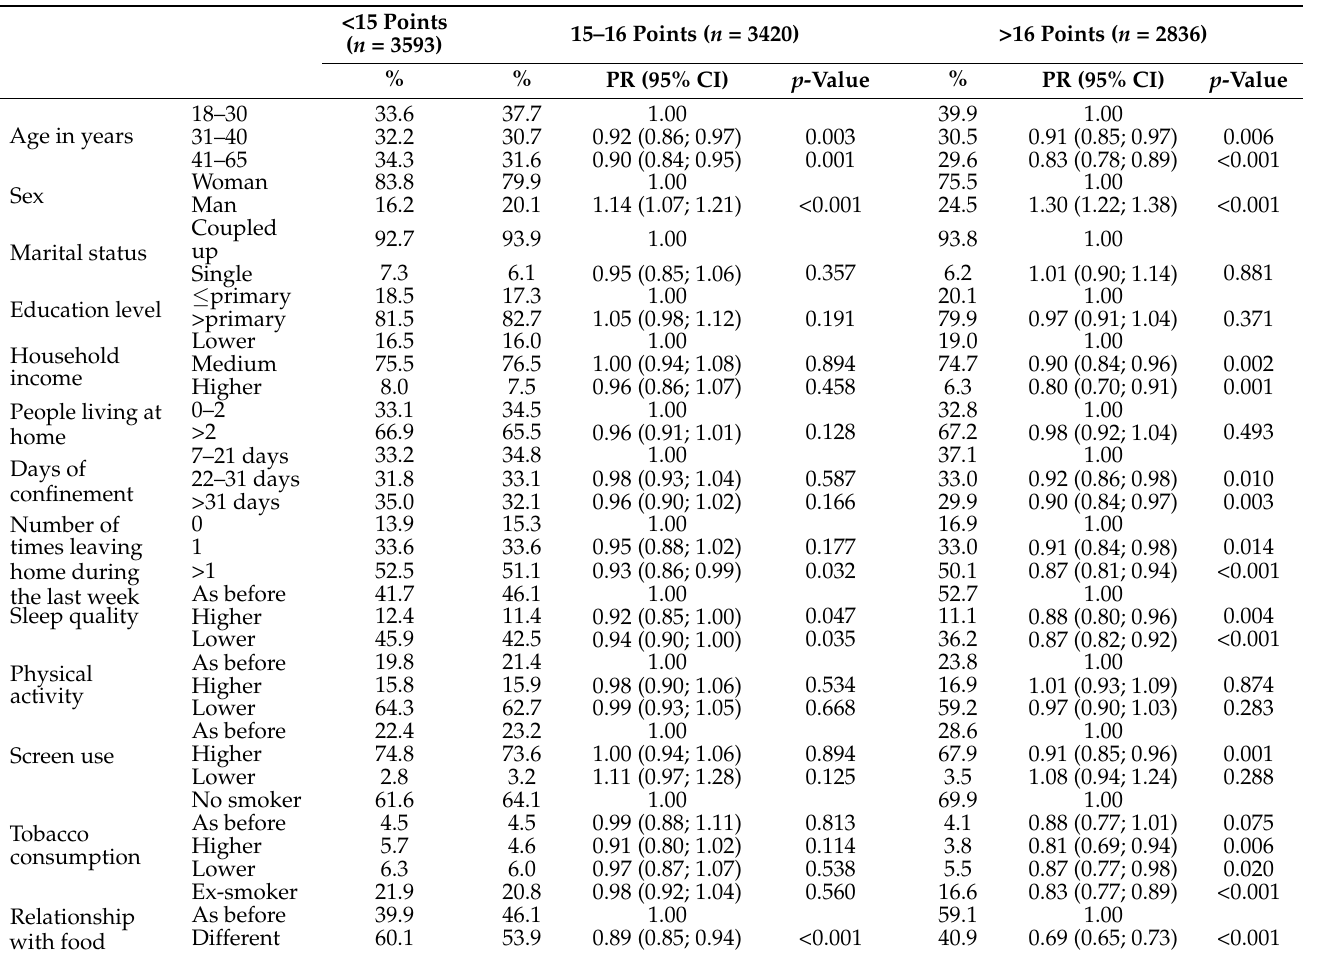
Table 2. Associated factors with medium (15–16 points) and high (>16 points) scores of cognitive restrained in the participants in the CoV-Eat project ( n =